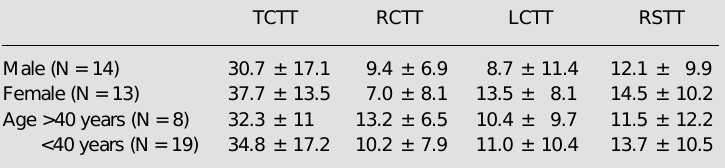
Table 3 - Effect of age and gender on total and segmental colonic transit times (CTT) in 27 healthy volunteers. Results are reported as mean ± SD hours. For abbreviations see legend to Table